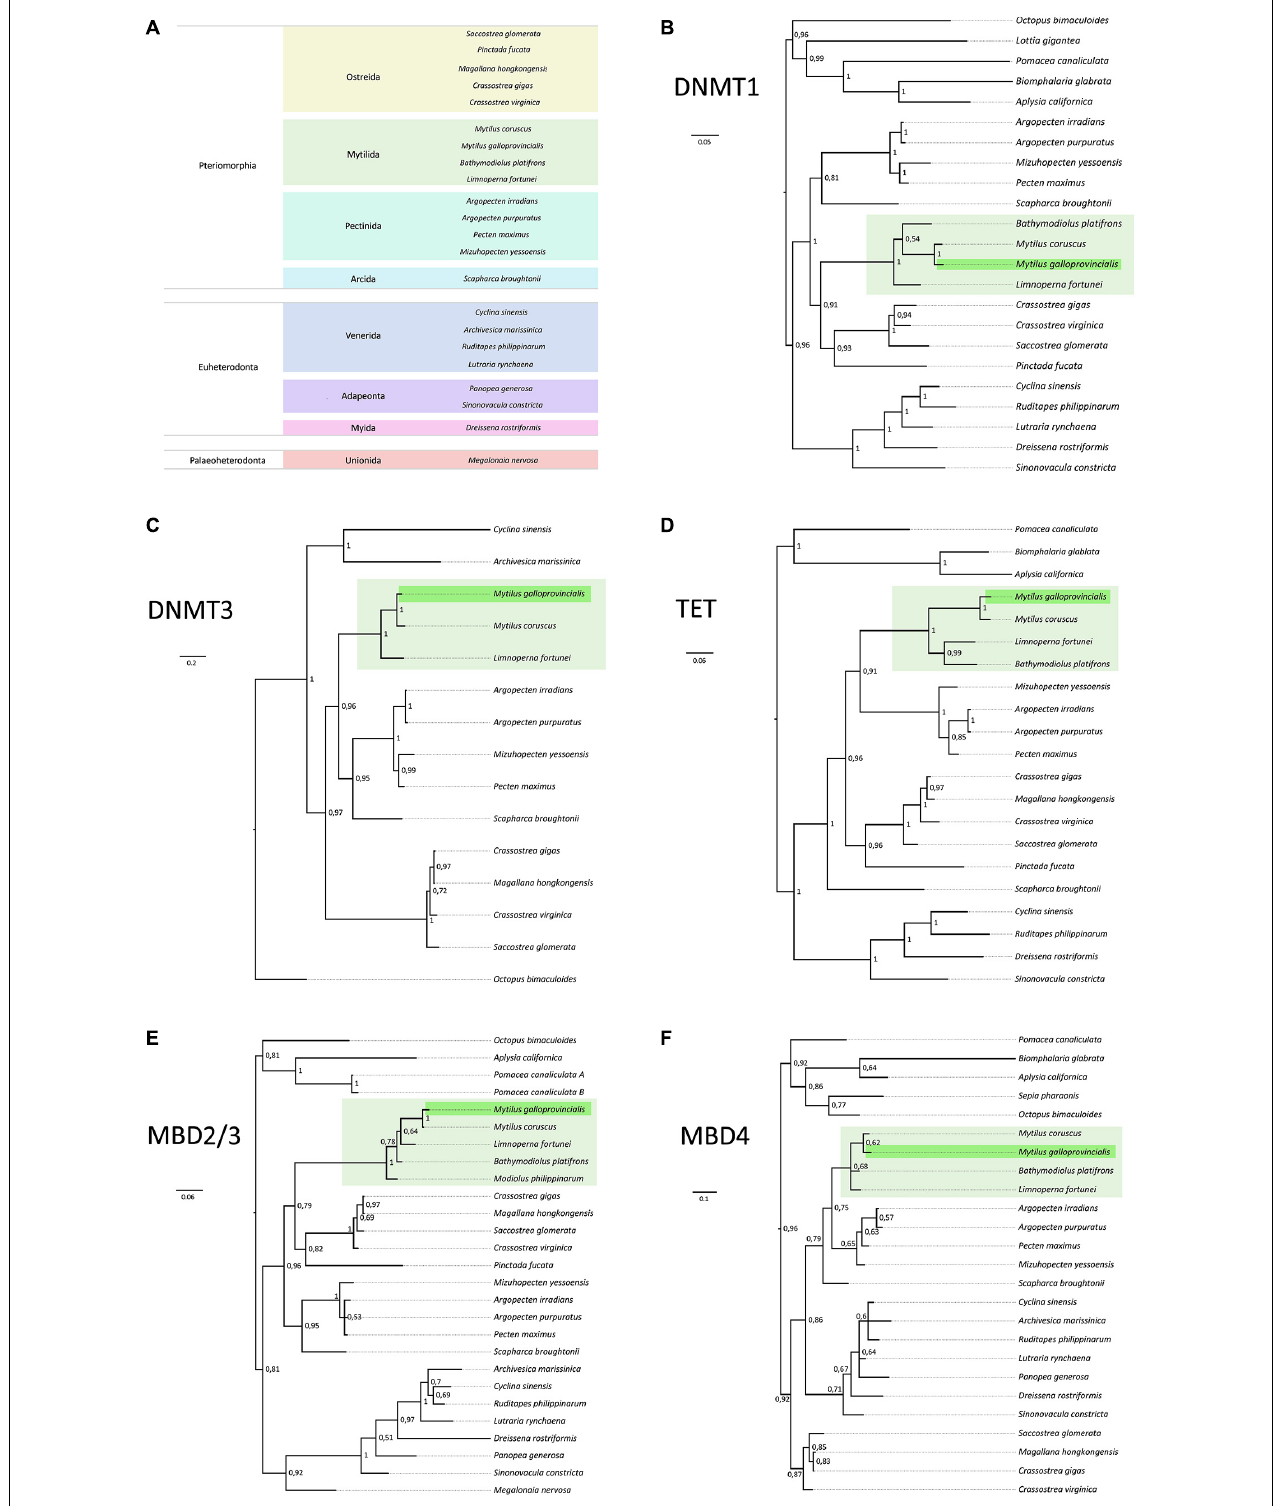
FIGURE 5 | (A) Taxonomic classification (infraclass and order) of the bivalve species considered in this study. (B–F) Bayesian phylogeny of bivalve DNMT1, DNMT3, TET, MBD2/3, and MBD4 orthologs. Sequences from M. galloprovincialis and mytilid bivalves are highlighted with a green and light green background, respectively. Posterior probability support values are shown close to each node. Poorly supported nodes (posterior probability < 0.5) have been collapsed in polytomies.